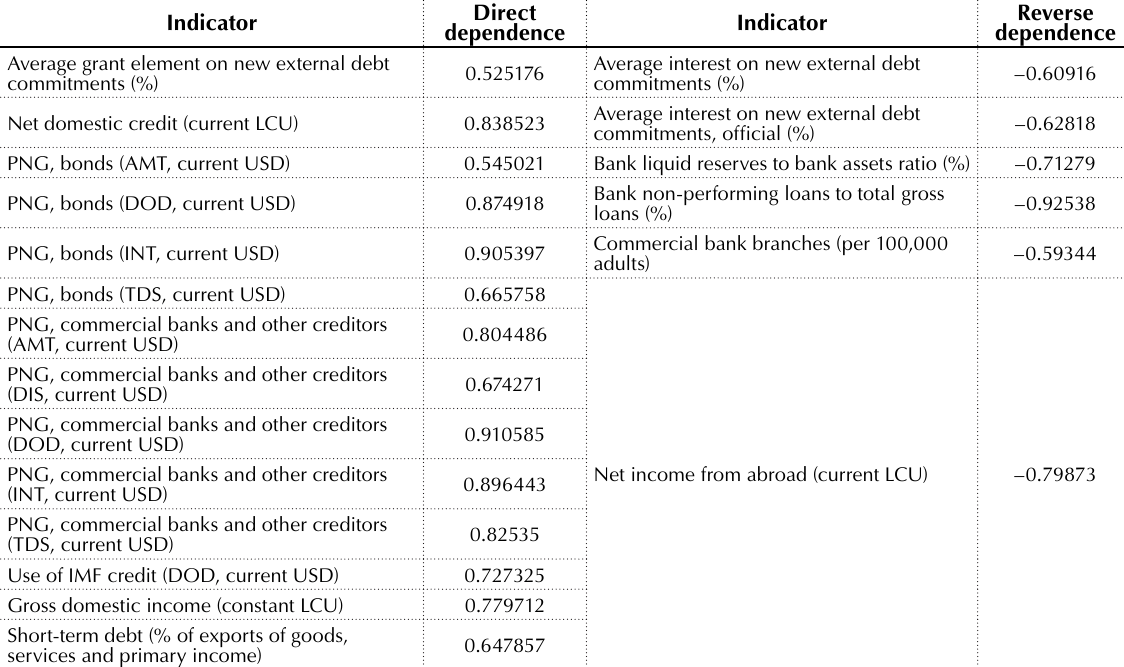
Table 3. Correlation coefficients of the dependence of the domestic loans provided by the financial sector with the researched